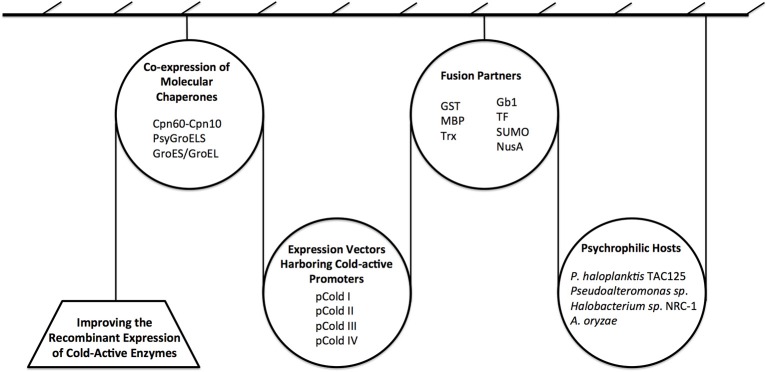
Overview of novel strategies for improving the recombinant expression of cold-active enzymes. Currently, the main approaches to produce enzymes at low temperatures include the use of: molecular chaperones, cold-active promoters, fusion partners, and psychrophilic hosts. A combination of the above strategies can also be used.